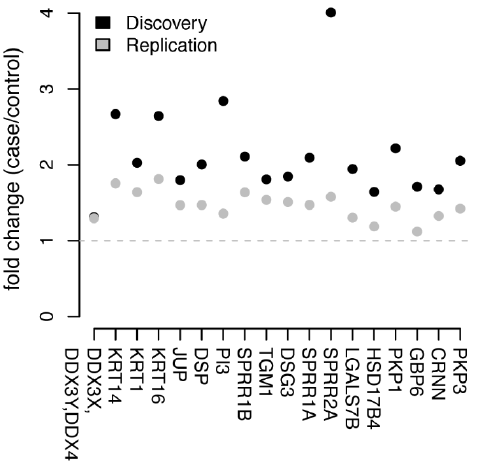
Figure 3. Trend of protein abundance as fold-change. Comparison between the discovery (black) and the replication (grey) cohorts of the trend distribution among CIN2+ and HPV-negative samples. Ratio values represented as fold-change, where values above one (1) represent CIN2+ with higher protein abundance than HPV-negative samples.